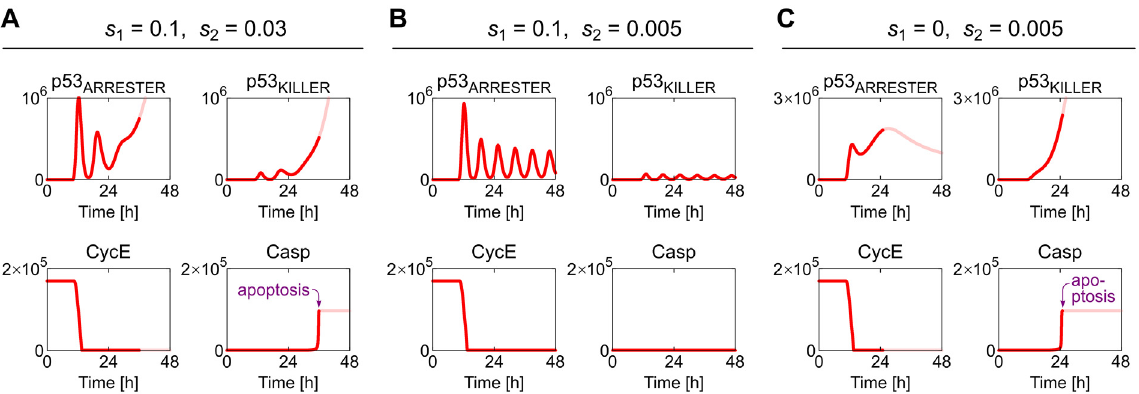
Fig 6. Deterministic simulation trajectories of the system with the suppressed DNA repair and either nominal or perturbed mRNA synthesis rates in response to 2-Gy irradiation. (A) Nominal Wip1 and PTEN mRNA synthesis rates ( s 1 = 0.1, s 2 = 0.03). (B) Decreased PTEN mRNA synthesis rate ( s 2 = 0.005). (C) Decreased PTEN mRNA synthesis rate ( s 2 = 0.005) and zero Wip1 synthesis rate ( s 1 = 0). The simulation started at Time = 0 h from the steady state corresponding to the resting (unstimulated) cell. At Time = 10 h the irradiation phase started and lasted for 10 min. The faded line visualizes the trajectory after the initiation of apoptosis, and thus must be interpreted with